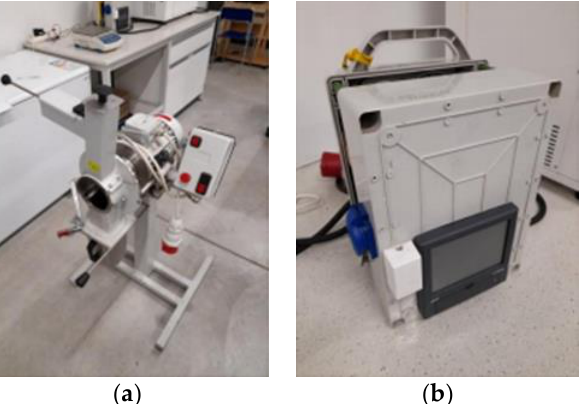
Figure 4. Equipment used for the grindability test: LMN 400 knife mill ( a ) and energy consumption analyzer ( b ).